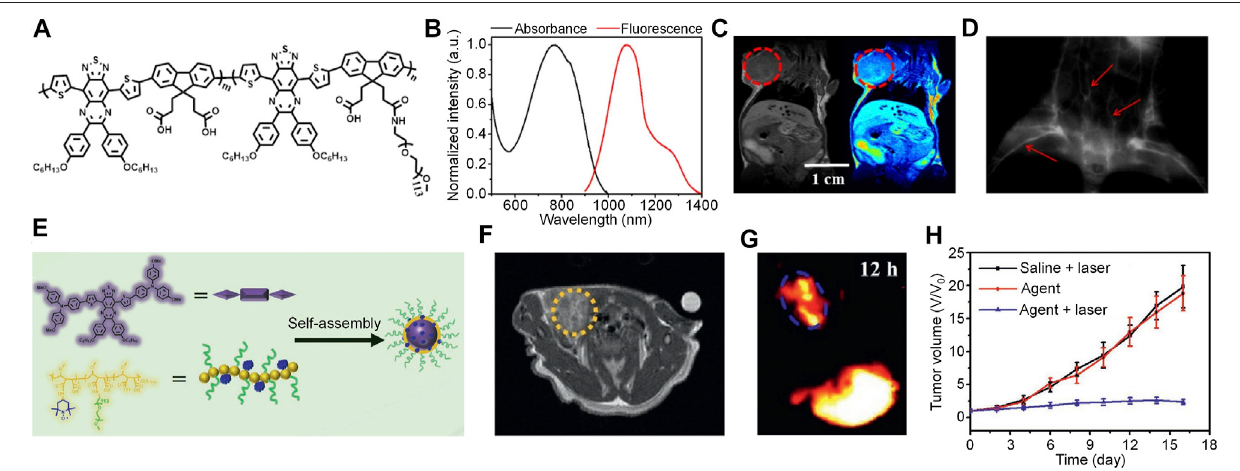
FIGURE 2 |(A) Chemical structure ofPFTQ-PEG. (B) Absorption and emission spectra of PFTQ-PEG-Gd NPs. (C) Whole body MRI images ofmice after injection ofPFTQ-PEG-Gd NPsfor24 h. Theredcircles indicate thelocationoftumor. (D) NIR-II fl uorescenceimage ofblood vessels ofmouse injected withPFTQ-PEG-Gd NPs for2 min.Theredarrowsindicatethelocationofbloodvessels. (E) SchematicillustrationofTPATQ-PNPNPspreparation. (F) RepresentativeMRIimageofmicetreated withTPATQ-PNPNPsfor12 h.Theyellowcircleindicatesthelocationoftumor. (G) NIR-II fl uorescenceimageoftumorbearingmouseinjectedwithPFTQ-PEG-Gd NPsfor12 h.Thebluecircleindicatesthelocationofthetumor. (H) Tumorvolumeofmiceasafunctionoftimeunderdifferenttreatments.Adaptedfrom(Huetal.,2019; Hu et al., 2021). Copyright © 2019 Ivyspring International Publisher, 2021 Wiley-VCH Verlag GmbH & Co. KGaA, Weinheim.